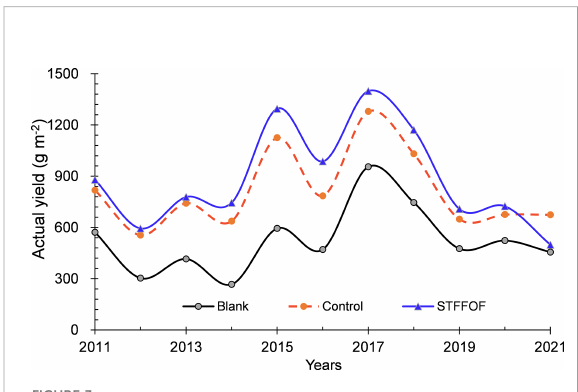
FIGURE 3 Effect of soil-testing formula fertilization using organic fertilizer for 11 years on the actual grain yield of